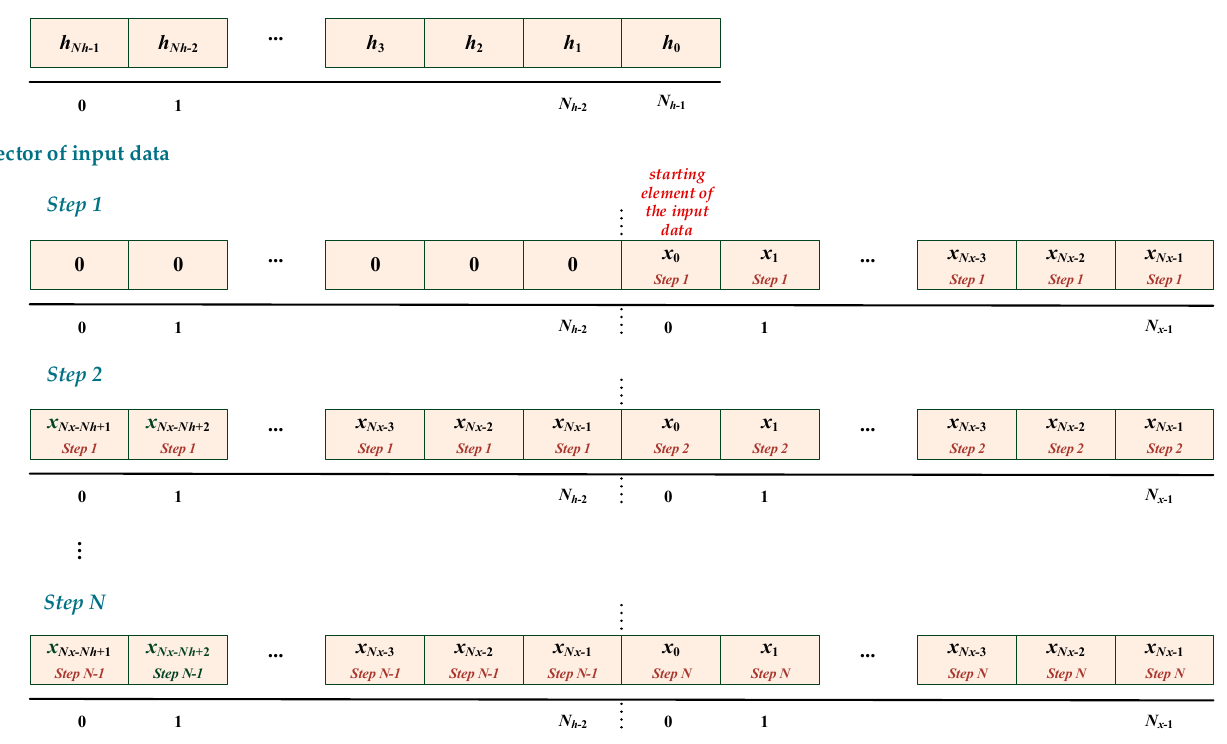
Figure 10. The scheme of operations on the input data subject to calculations.